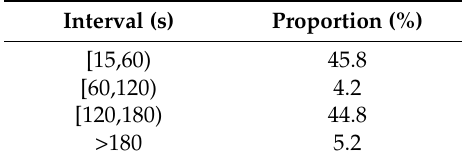
Table 1. A rough interval distribution of the rows with missing data.